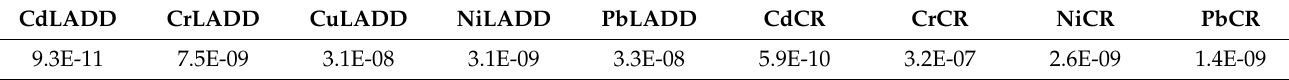
Table 5. Mean values for Cancer Risk for each